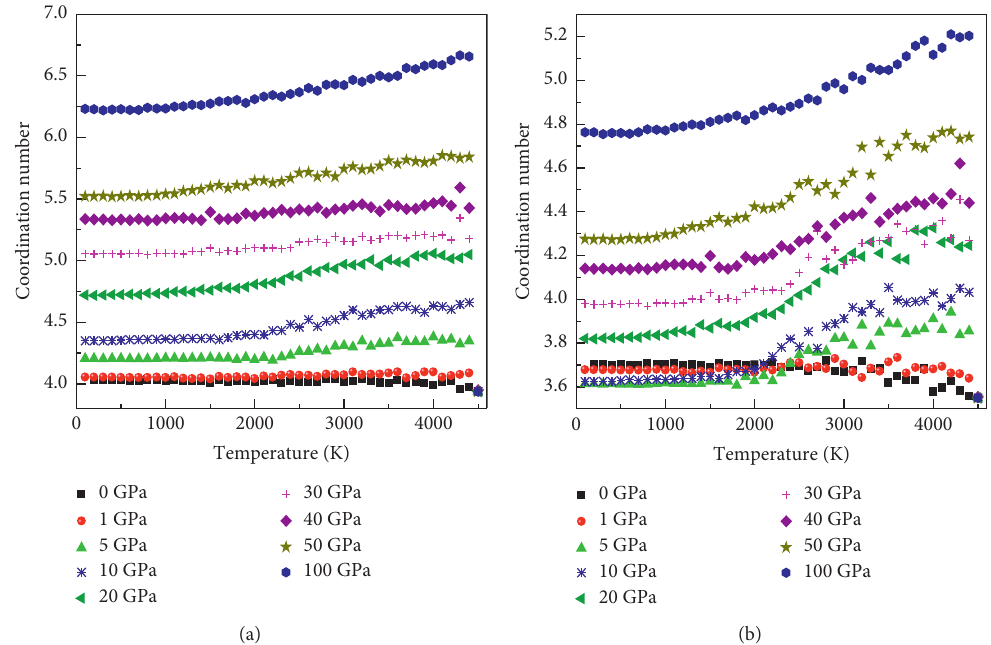
Figure 5: Change in the CN of Si and C atoms with temperature under different